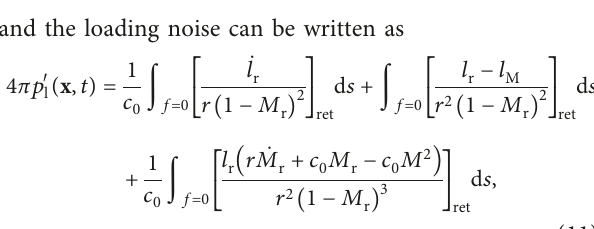
Figure 1: Solution diagram of the vortex lattice bound to the ECR blade surface and new vortex